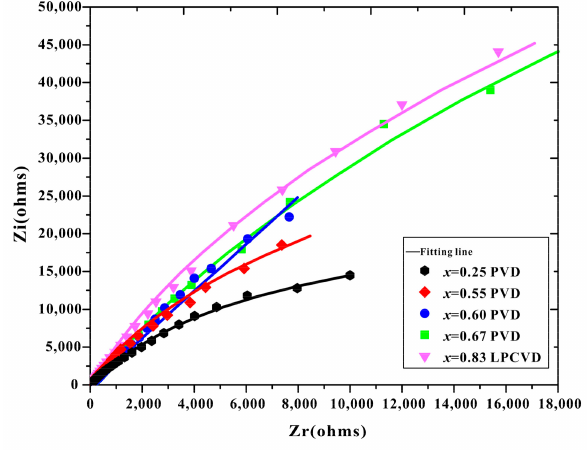
Figure 4. Nyquist plots of the Ti 1 − x Al x N coatings in a 3.5 wt.% NaCl solution. Symbols are experi- mental data, and solid lines are fitting results.